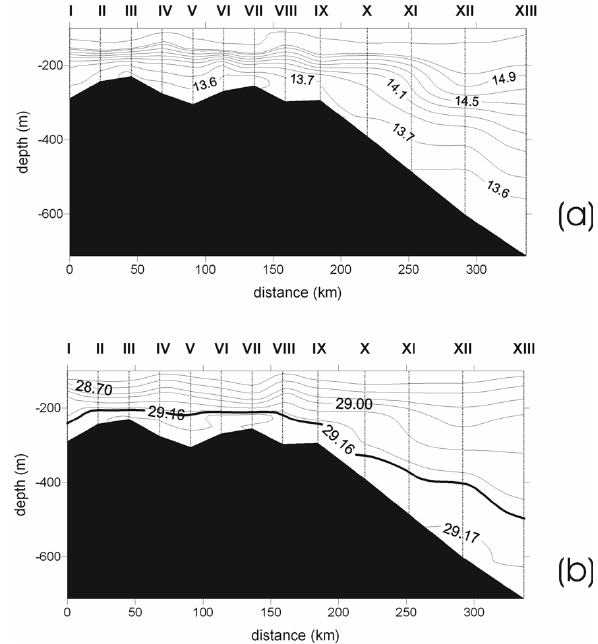
Figure 4. Vertical section along the vein trajectory indicated in Figure 1b. (a) Potential Fig. 4. Vertical section along the vein trajectory indicated in Fig. 1b. Temperature; (b) Potential Density. (a) Potential Temperature; (b) Potential